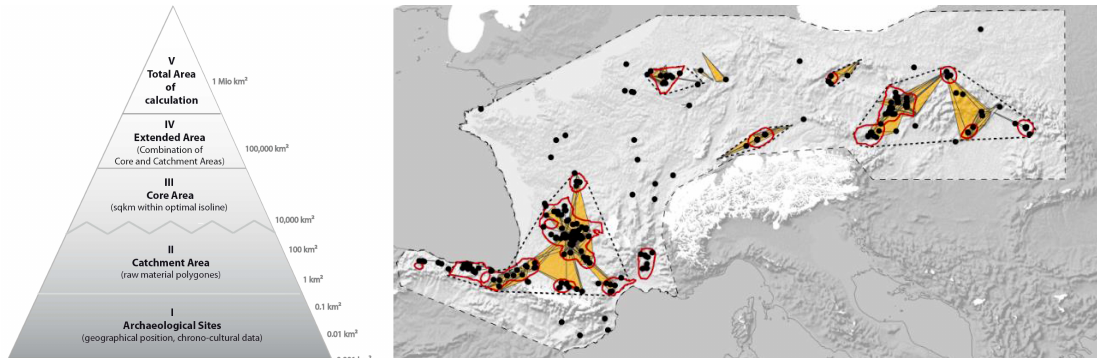
Figure 11. Hierarchical scale model of the Cologne Protocol for the estimation of population densities during the Upper Paleolithic in Europe ( left , after [70]), and a map on central Europe, with Core Areas (red lines), Extended Areas (dotted lines), and the Total Area of Calculation (dashed line) for a case study of the early Upper Paleolithic ( right , after